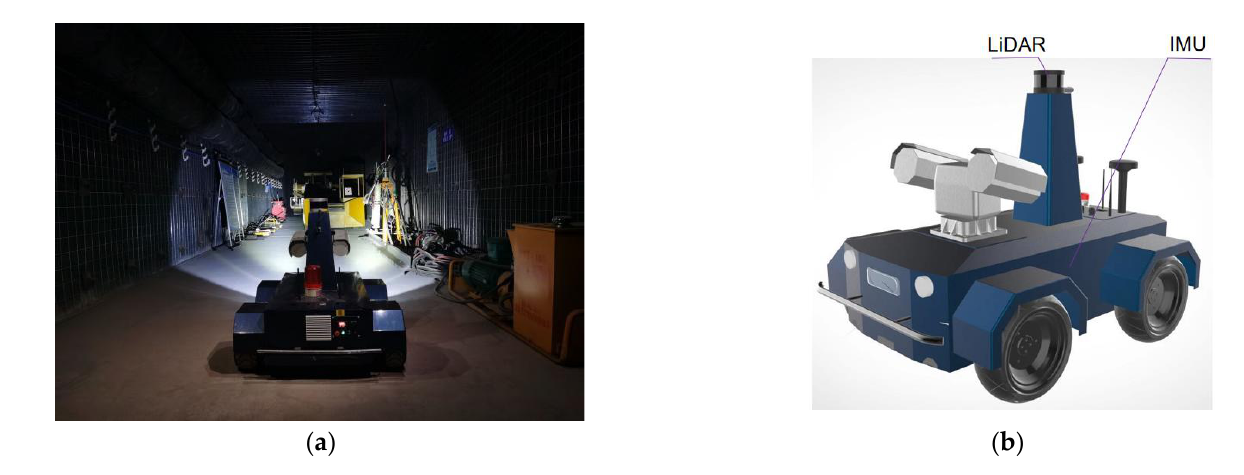
Figure 4. Wheeled mobile robot. ( a ) Physical picture of mobile robot; ( b ) 3D model of mobile robot.